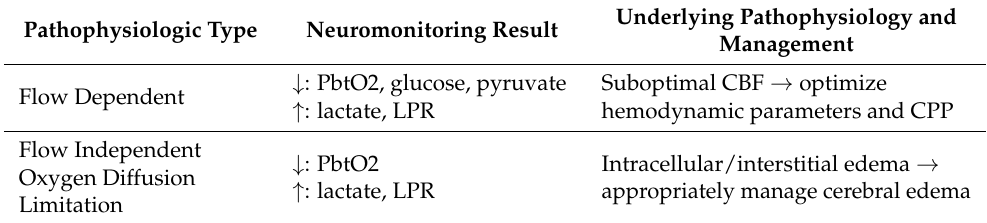
Table 3. Pathophysiologic Types of Cerebral Shock (adapted from Brain Shock-Toward Pathophysi- ologic Phenotyping in Traumatic Brain Injury [78]). Brain tissue oxygen (PbtO2); lactate/pyruvate ratio (LPR); cerebral blood flow (CBF); cerebral perfusion pressure (CPP); intracranial pressure (ICP); cortical spreading depression (CSD). If a neuromonitoring result is not listed, it is either unchanged or